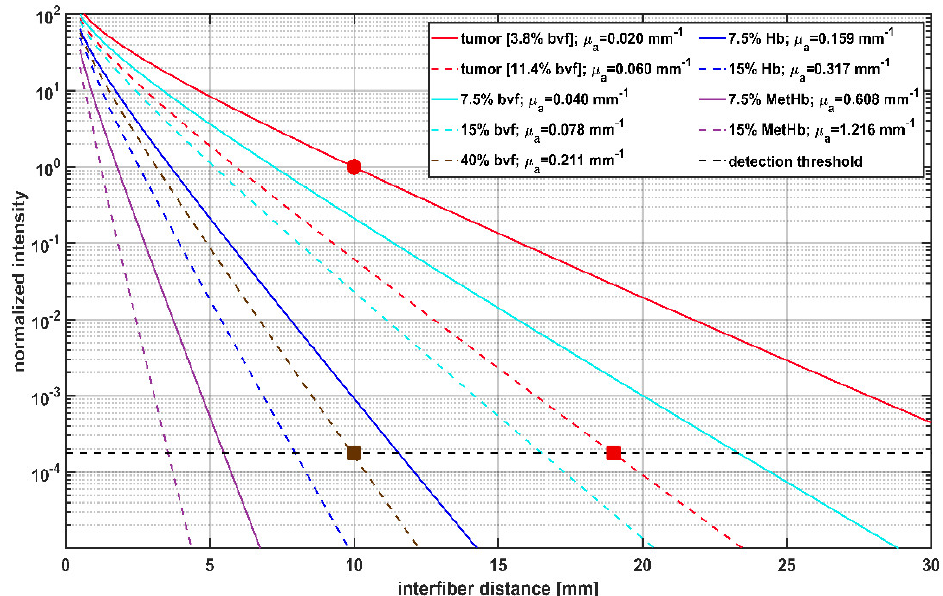
Figure 4. Calculation of transmitted light intensity at 635 nm between cylindrical diffuser fibers (CDFs) with a 2 cm diffuser length, and its dependency on the interfiber distances for different blood volume fractions (bvf) and hemoglobin species. Blood is approximated to contain 85% HbO 2 and 15% Hb. Transmitted light intensities are normalized to tumor ( µ a = 0.02 mm − 1 , µ s’ = 2 mm − 1 ) at 10 mm interfiber distance (red circle). The legend shows the different blood volume fractions of hemoglobin species and the resulting µ a assumed for the calculation with µ s ’ set constant to 2 mm − 1 . The horizontal dashed line at 1.9 × 10 − 4 shows the estimated detection threshold of the iPDT SOM setup. The red square indicates that in case of a tumor with 11.4% bvf the detection threshold is reached at an interfiber distance of 19 mm. The brown square shows that for 40% bvf the detection threshold is already reached at an interfiber distance of 10 mm.